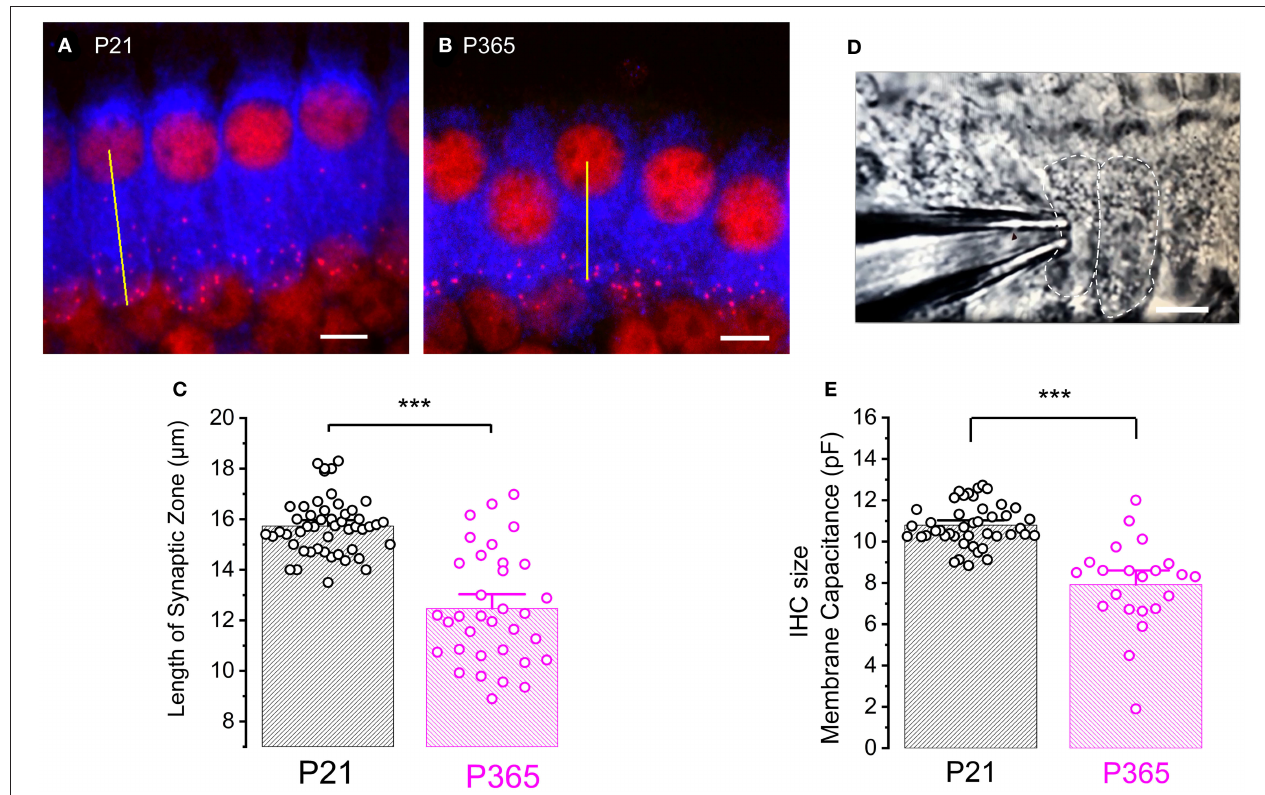
FIGURE 6 | Cell size reduction of IHCs with aging. (A,B) Immuno-confocal imaging of IHCs labeled for myo-7a (blue) and CtBP2 (labeling the ribbons, red) in P21 (A) and P365 (B) mice (reconstructed stack images of 22 slices of 0.3 µ m thick). The length of the infra-nuclear synaptic zone was measured from the center of the nucleus to the bottom of the cell as indicated by the yellow line. The scale bar indicated 5 µ m. (C) Comparative histogram of the length of the infra-nuclear synaptic zone. Asterisks indicated statistical significance with p < 0.0001, unpaired t -test, n = 50 IHCs for P21 and 34 IHCs for P365. Measurements were made from IHCs of the mid-cochlear region (8–16kHz). (D) Photomicrograph showing a row of IHCs in an ex-vivo organ of Corti explant and a patch-clamp recording electrode allowing measurements of capacitive and ionic currents. (E) Comparative mean IHC resting membrane capacitance, measured at − 70mV, in whole-cell patch-clamp configuration. Asterisks indicated values with significant difference with p < 0.0001, unpaired- t test, n = 44 IHCs for P21 and n = 22 for